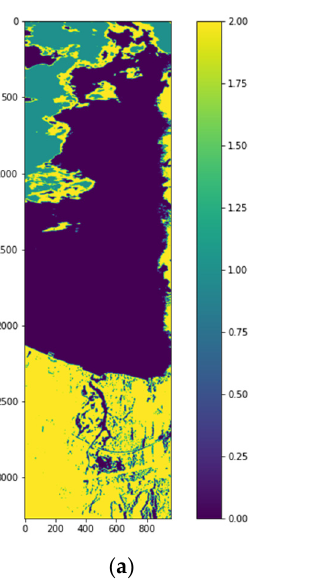
( c ) Figure 10. Confusion matrices for classification of HSI2 Image 1 into 3 classes for a batch size of 1500 using 3 PCA bands with the three types of scaling methods ( a ) normalization scaling (ns), ( b ) max- imum scaling (ms), ( c ) scaling (sc)). The three classes are indicated as W—water, C—clouds, L— land.